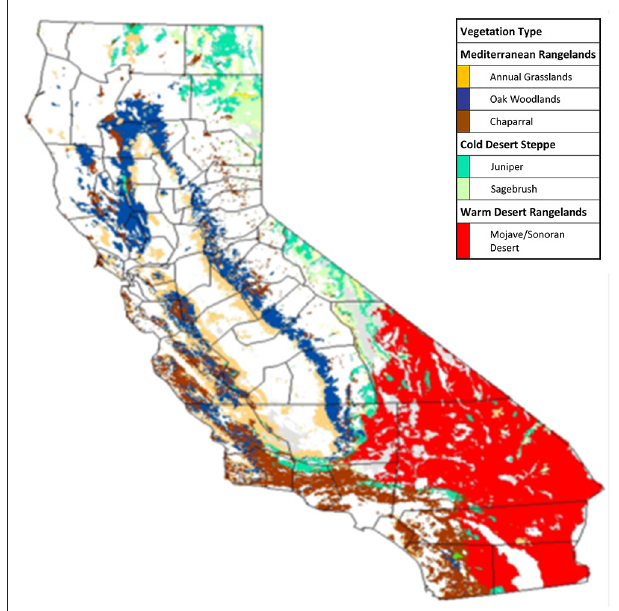
FIGURE 1 | Location of major California rangeland vegetation types (adopted from George et al., 2015). Lands colored white are non-range landcover types (e.g., forest, urban, more intensive